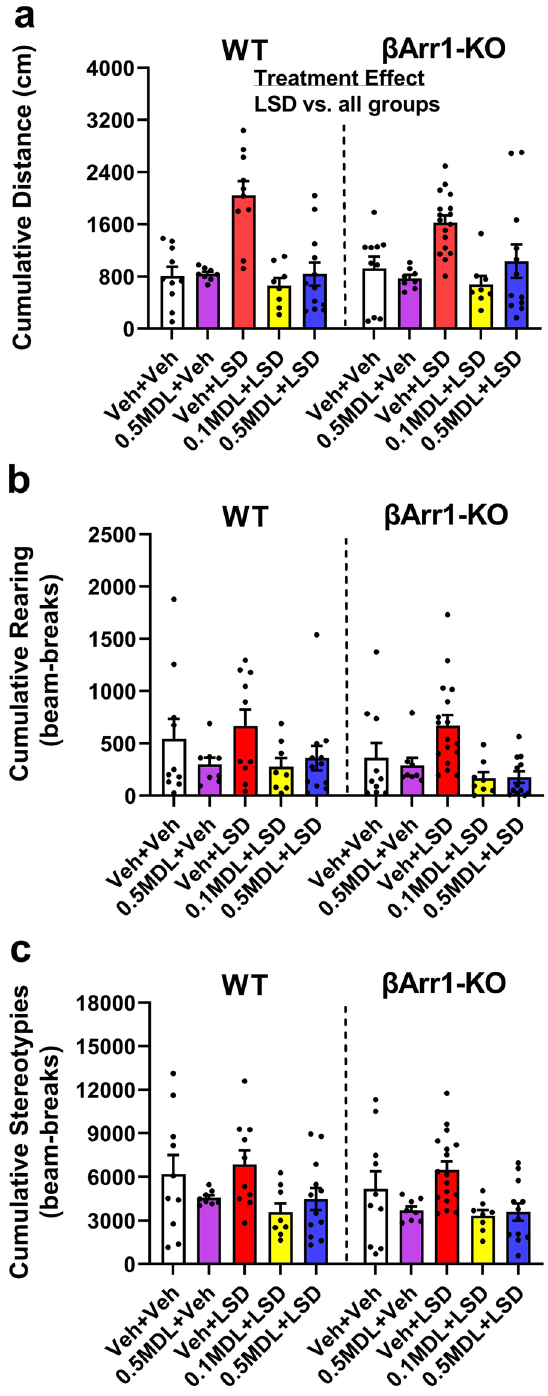
Figure 1. Effects of LSD and MDL100907 on cumulative motor activities in β-arrestin 1 mice. Mice were administered the vehicle or different doses of MDL100907 (MDL) and placed into the open field for 30 min. They were removed, injected with the vehicle or 0.3 mg/kg LSD, and immediately returned to the test arena for 90 min. The cumulative baseline motor activities (0–30 min) are presented in Supplementary Table S1. A two-way ANOVA failed to identify any significant effects for baseline locomotion; separate two-way ANOVAs detected significant treatment effects for baseline rearing [F(4,93) = 6.943, p < 0.001] and stereotypical activities [F(4,93) = 7.110, p < 0.001]. To control for these baseline differences in rearing and stereotypy, the LSD post-injection activities were analyzed by ANCOVA. ( a ) LSD-stimulated locomotor activities in WT and βArr1-KO mice. A two-way ANOVA identified a significant treatment effect [F(4,93) = 16.916, p < 0.001]. ( b ) LSD-stimulated rearing activities in βArr1 animals. An ANCOVA failed to find any significant differences. ( c ) LSD-stimulated stereotypical activities in βArr1 mice. An ANCOVA revealed a significant treatment effect [F(4,92) = 7.029, P = 0.024]. N = 8–17 mice/group. Bonferroni corrected post-hoc tests for locomotion for treatment effects: p < 0.001, LSD vs. all